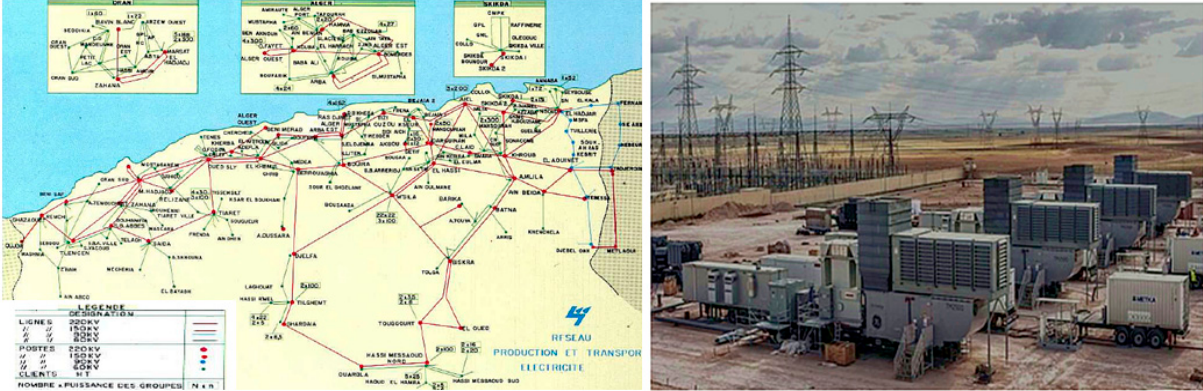
Figure 11. National energy grid of Algeria.